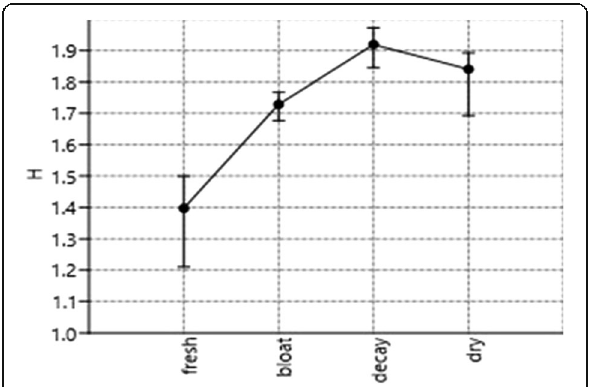
Fig. 2 Shannon index value for each cadaveric decomposition stage in the outdoor habitat